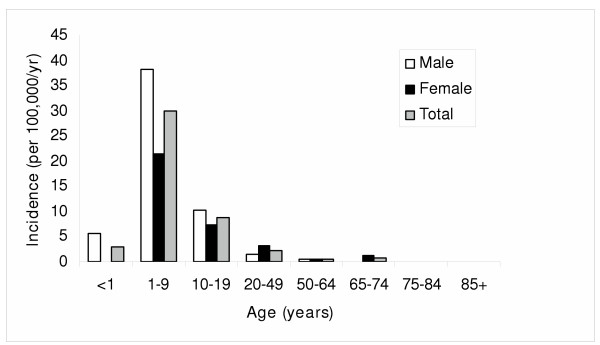
Age and gender specific incidence rates of Cryptosporidium sp. infection in the Calgary Health Region.